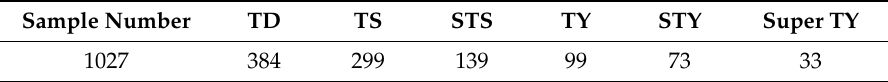
Table 2. Number of tropical cyclone (TC) samples by intensity. Tropical depression (TD), tropical